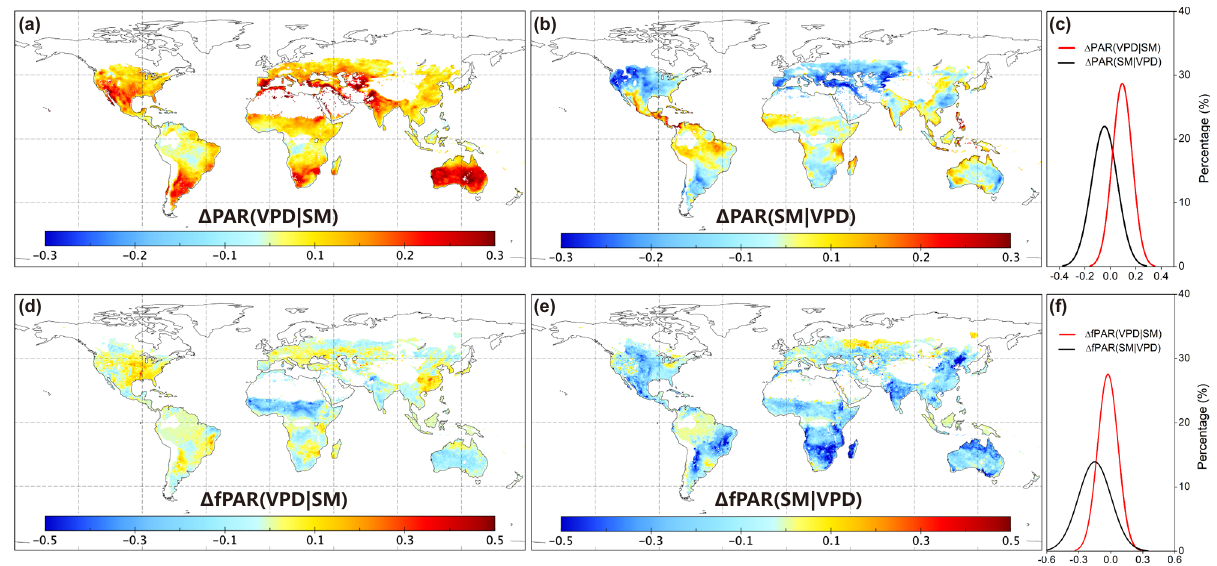
Fig. 1 Effects of soil moisture (SM) and vapor pressure de fi cit (VPD) on photosynthetically active radiation (PAR) and fraction of photosynthetically active radiation absorbed by plants (fPAR) globally. a , b Indicate the spatial distribution of the changes in PAR caused by high VPD ( Δ PAR(VPD|SM)) and low soil moisture (SM) ( Δ PAR(SM|VPD)), and c shows the probability density function of Δ PAR. d – f Indicate the corresponding changes of fPAR. For better comparability in space, the PAR and fPAR data time series were normalized by the average exceeding 90th percentile per pixel. The units refer to the fractions relative to average PAR and fPAR exceeding the 90th percentile in each grid cell. Regions with sparse vegetation and regions without valid data are masked in